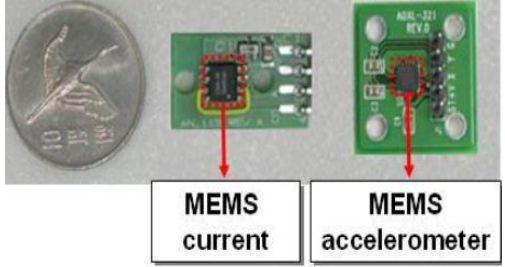
Figure 7. MEMS sensors for current and accelerometers, as shown in [66]. Reproduced with permission from Elsevier,